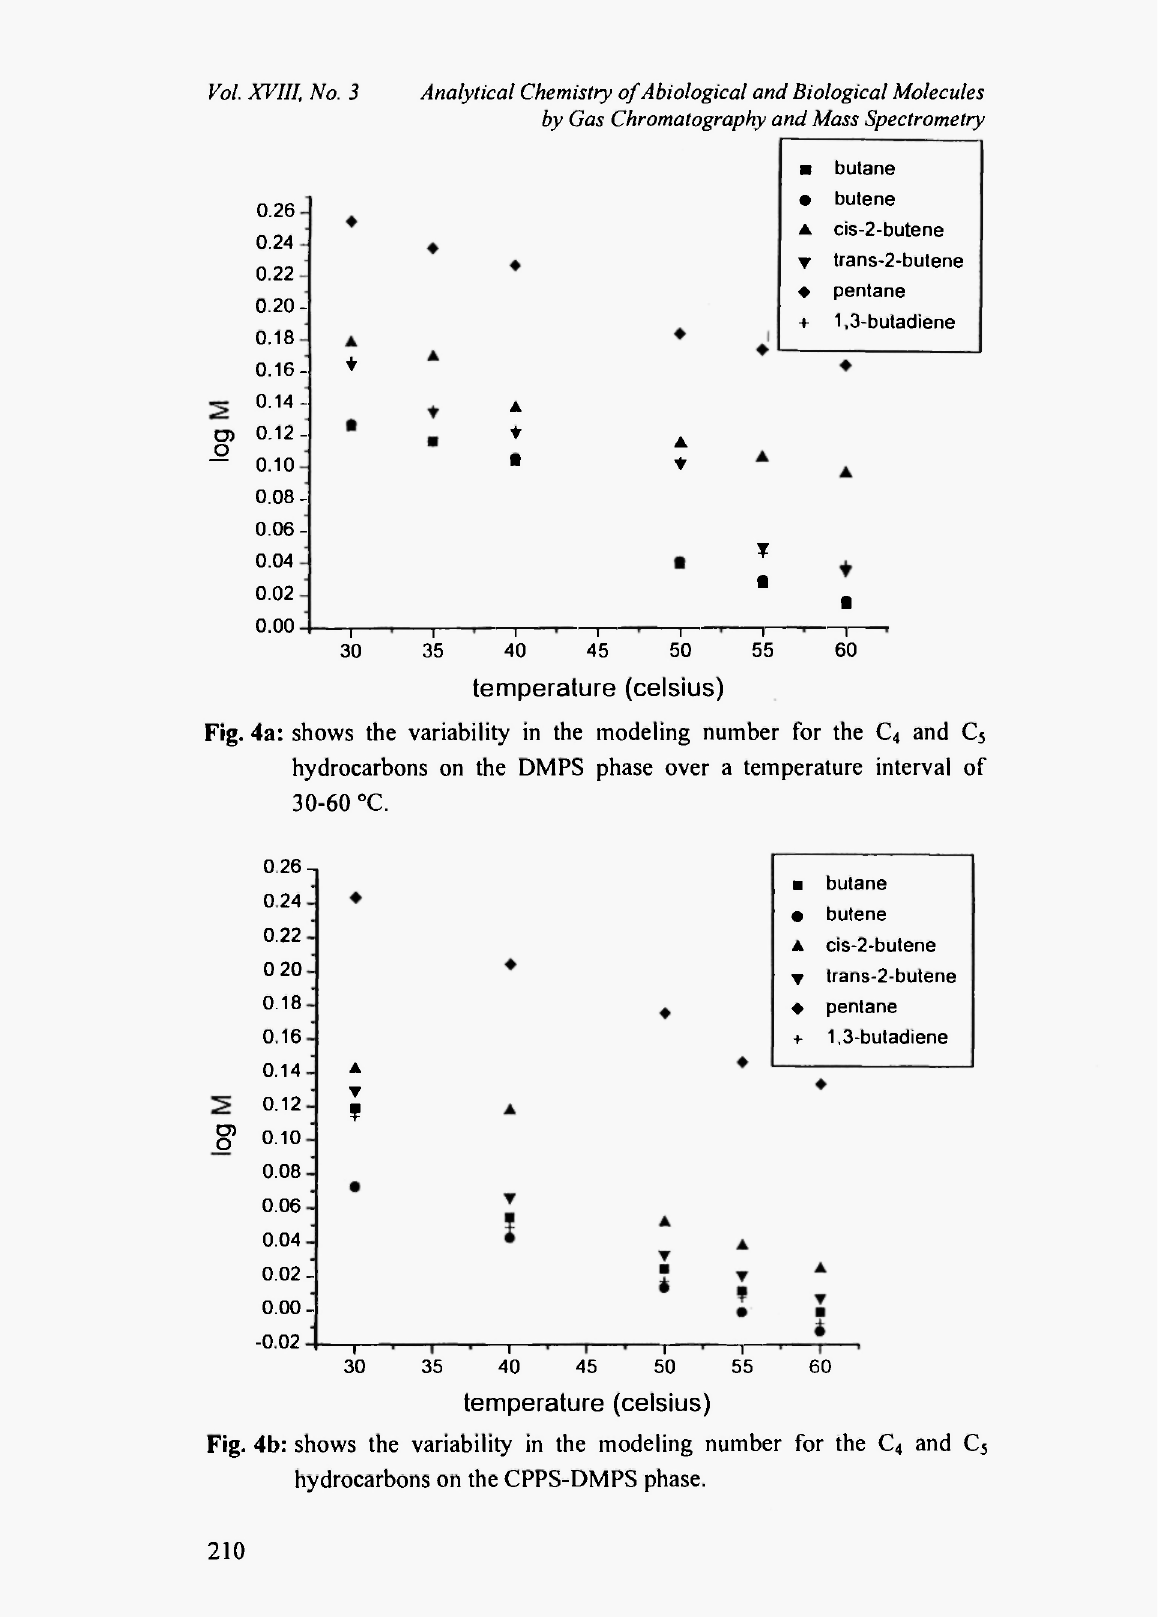
Fig. 4b: shows the variability in the modeling number for the C 4 and C 5 hydrocarbons on the CPPS-DMPS